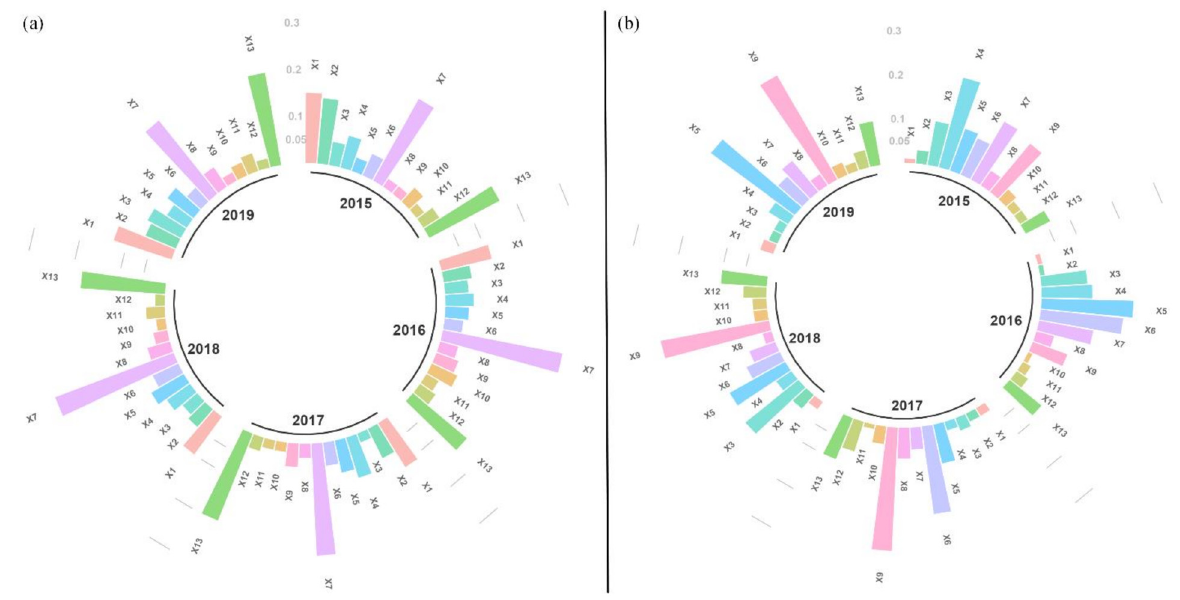
Figure 6. Spatial–temporal pattern of the factors affecting the long-term development of SAVs. ( a ) Vegetable SAVs, ( b ) cereal SAVs. The variables are × 1: elevation, × 2: slope, × 3: road network distance from SAVs to river, × 4: precipitation, × 5: soil quality, × 6: road network distance from SAVs to county, × 7: road network distance from SAVs to road network, × 8: road network distance from SAVs to the highway intersection, × 9: county urbanization population, × 10: county urbanization rate, × 11: disposable income of urban residents in the county, × 12: gross production value of the county, and × 13: number of agricultural enterprises in the